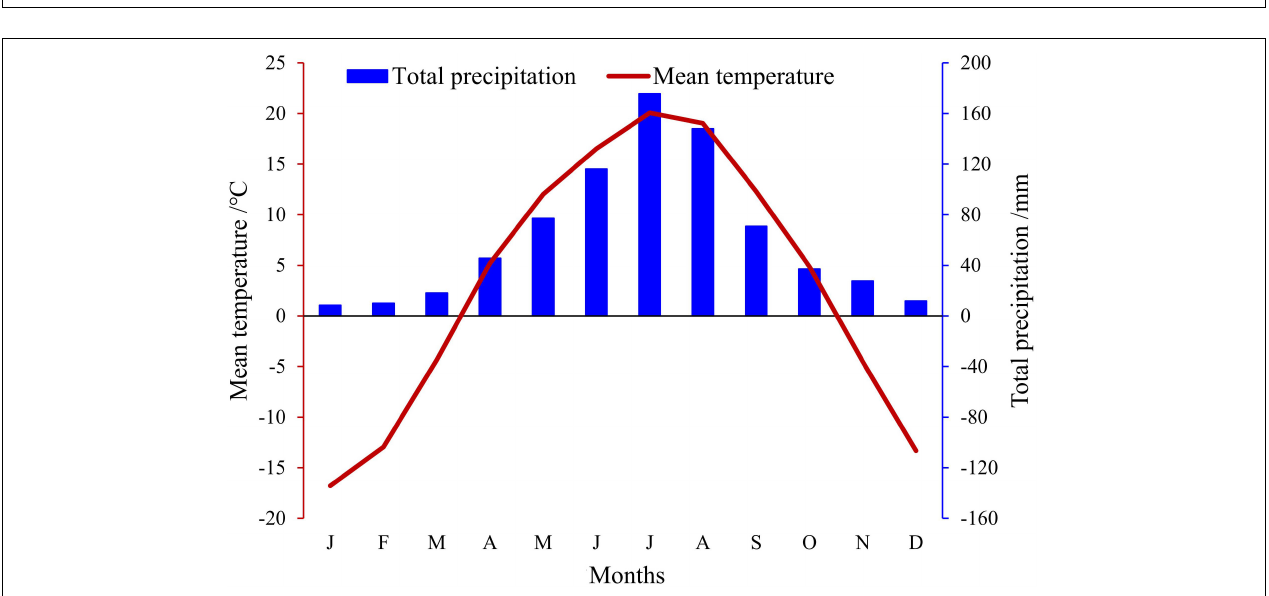
FIGURE 2 | Monthly total precipitation and mean temperature at Changbai Mountain based on the Donggang and Erdao meteorological stations (1958–2007).